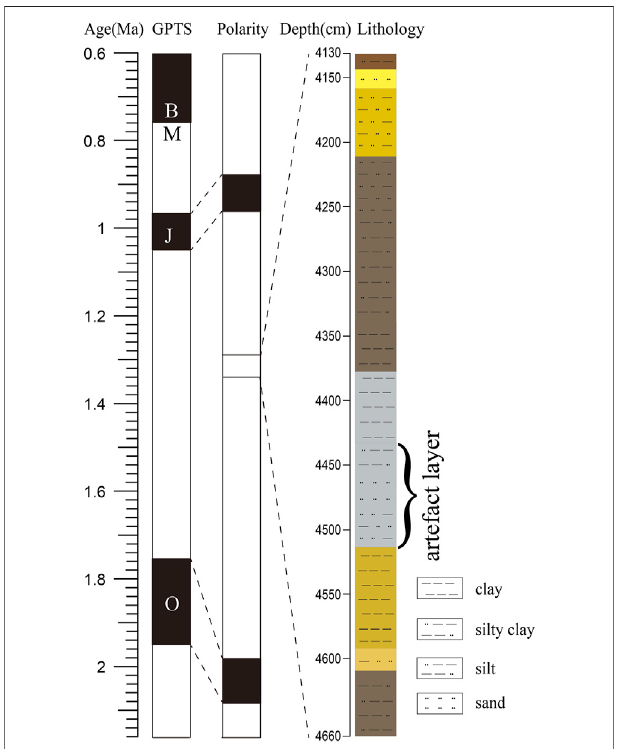
FIGURE 2 | Magnetostratigraphy and lithology of the Banshan site in Nihewan Basin (modi fi ed from Zhu et al., 2004).